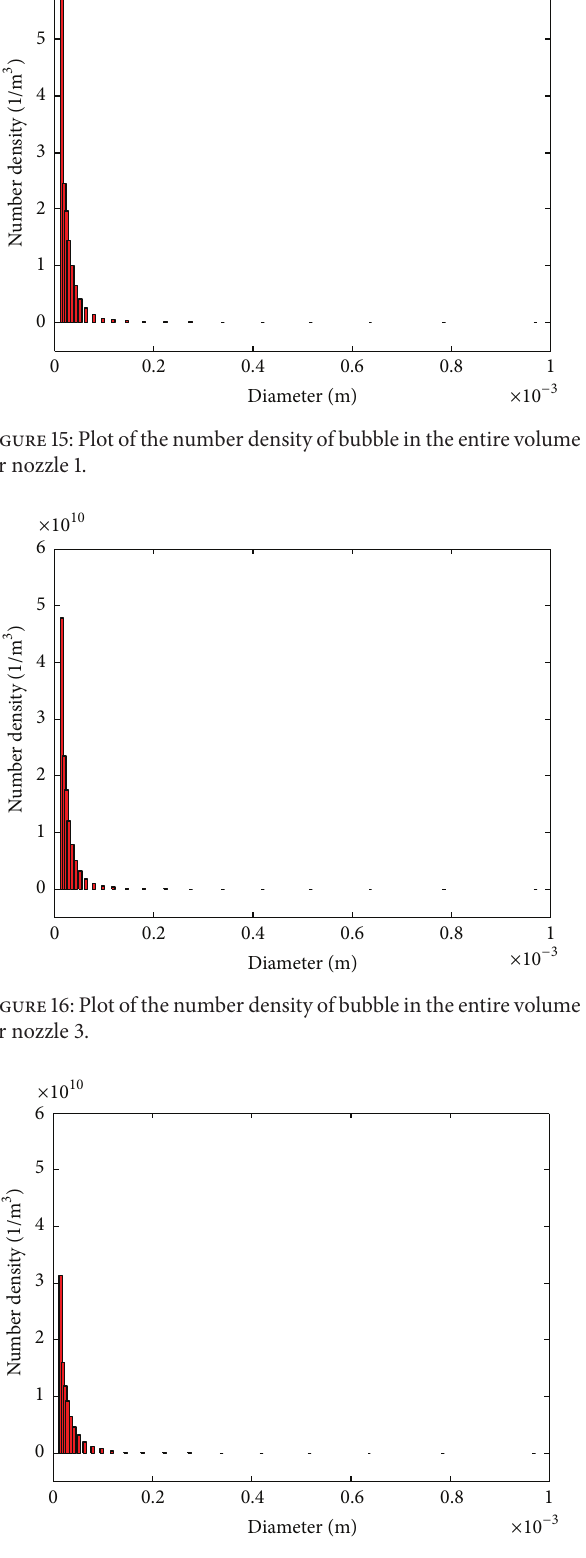
Figure 17: Plot of the number density of bubble in the entire volume for nozzle 5.